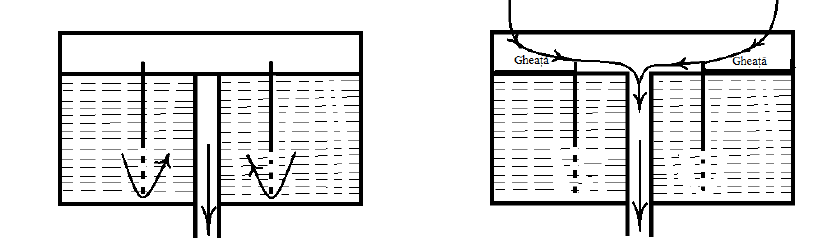
Figure 4. Directing water in the accumulator - 1, when the atmospheric temperature is t> 0 0 С (a) and t ≤ 0 0 С (b).